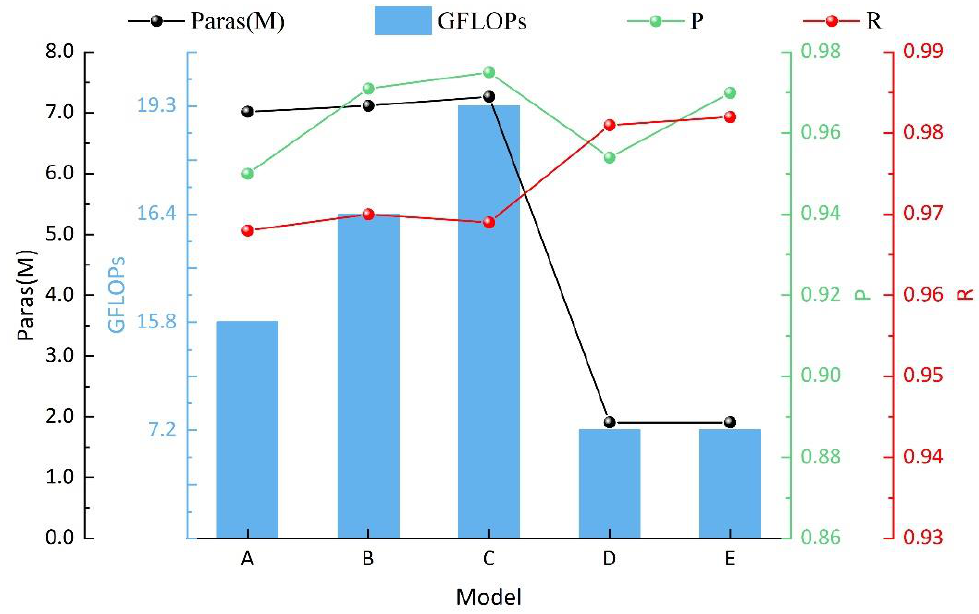
Figure 10. Results of ablation experiments.